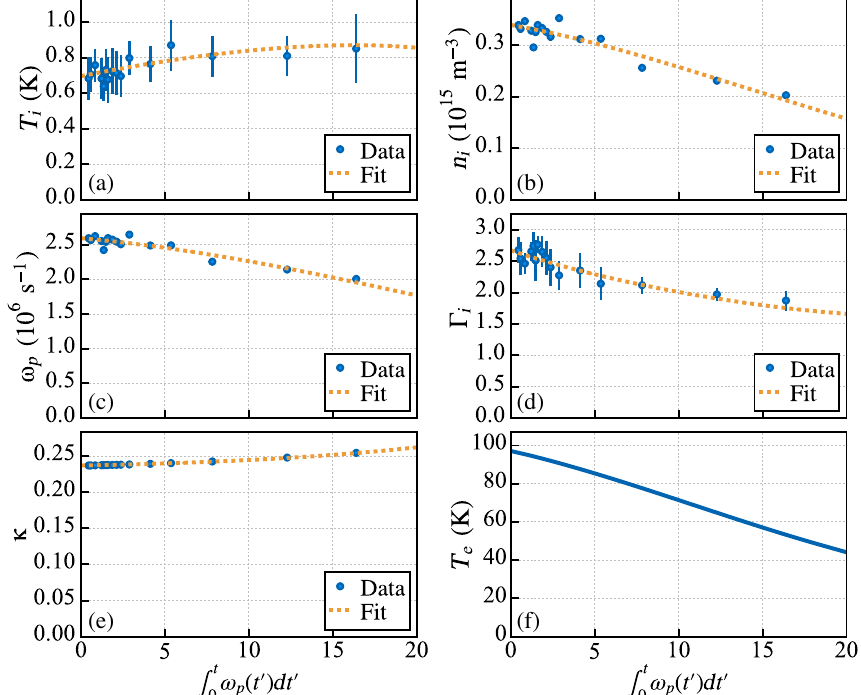
FIG. 6. Typical evolution of (a) T i , (b) n i , (c) ω p , (d) Γ i , (e) κ , and (f) T e versus scaled time with smooth